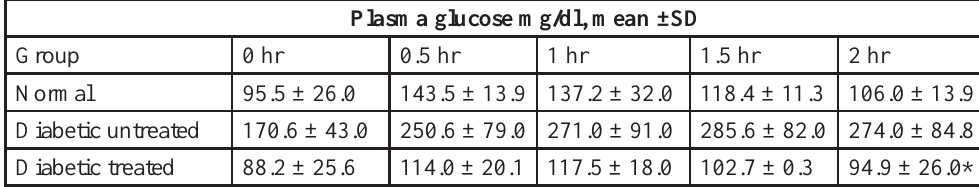
Adapted from Ali Hussain